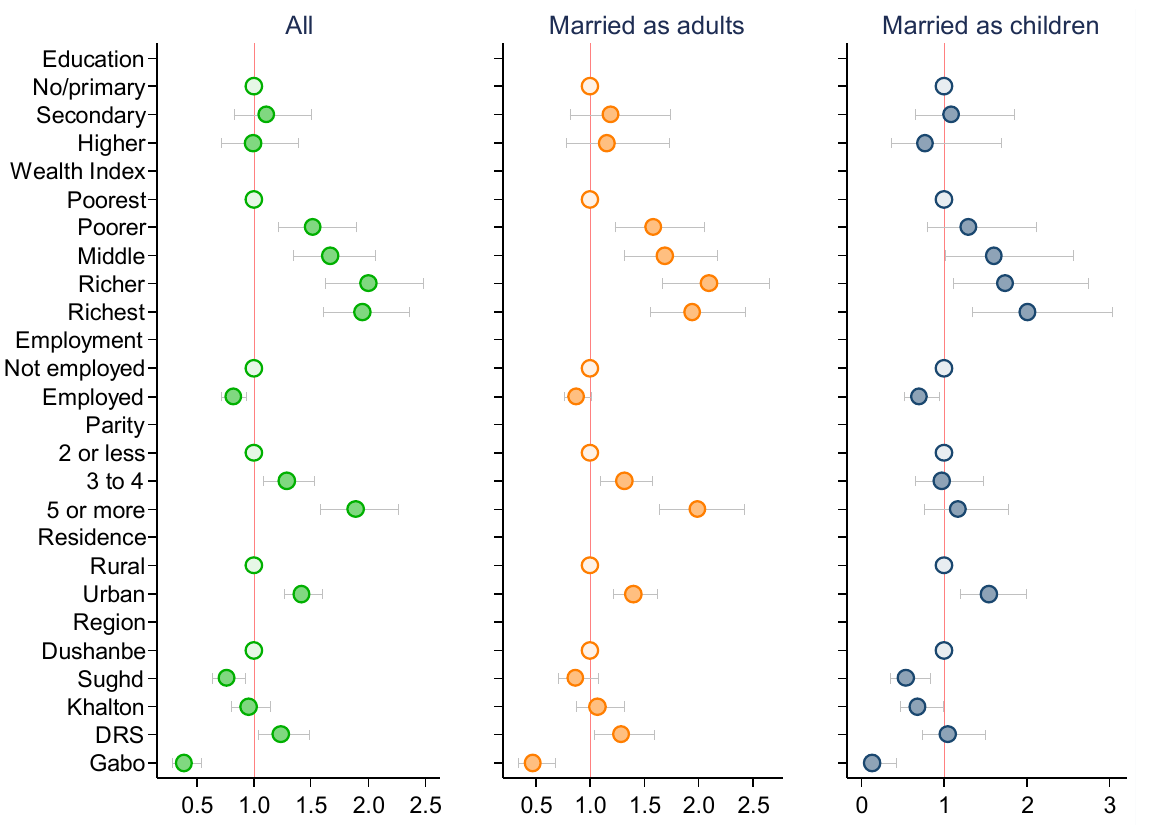
Figure 5. Crude odds ratios in favor of being obese for sociodemographic correlates. Horizontal lines across the markers represent 95% confidence intervals. Standard errors were obtained by bootstrapping with 1000 replications. Table 2. Odds ratios in favor being obese for the full